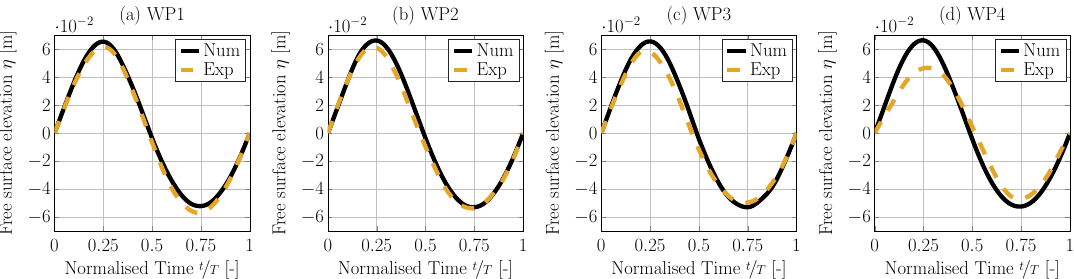
Figure 8. Phase-averaged free surface elevation, measured at wave probes WP1–WP4 ( a – d ), for wave